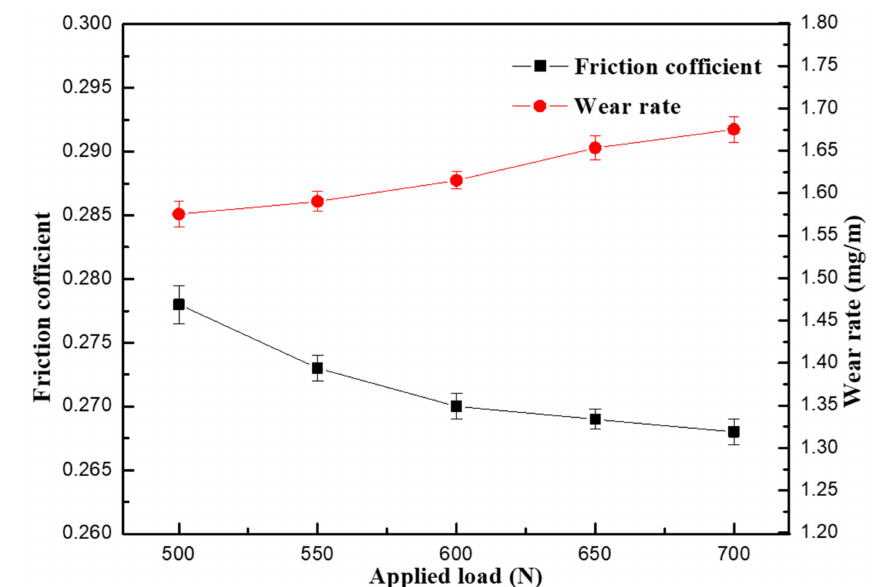
Figure 11. The curves of the friction coe ffi cient and wear rate of SiCp / Al-Si composite with 0.6 wt% CeO 2 content under di ff erent